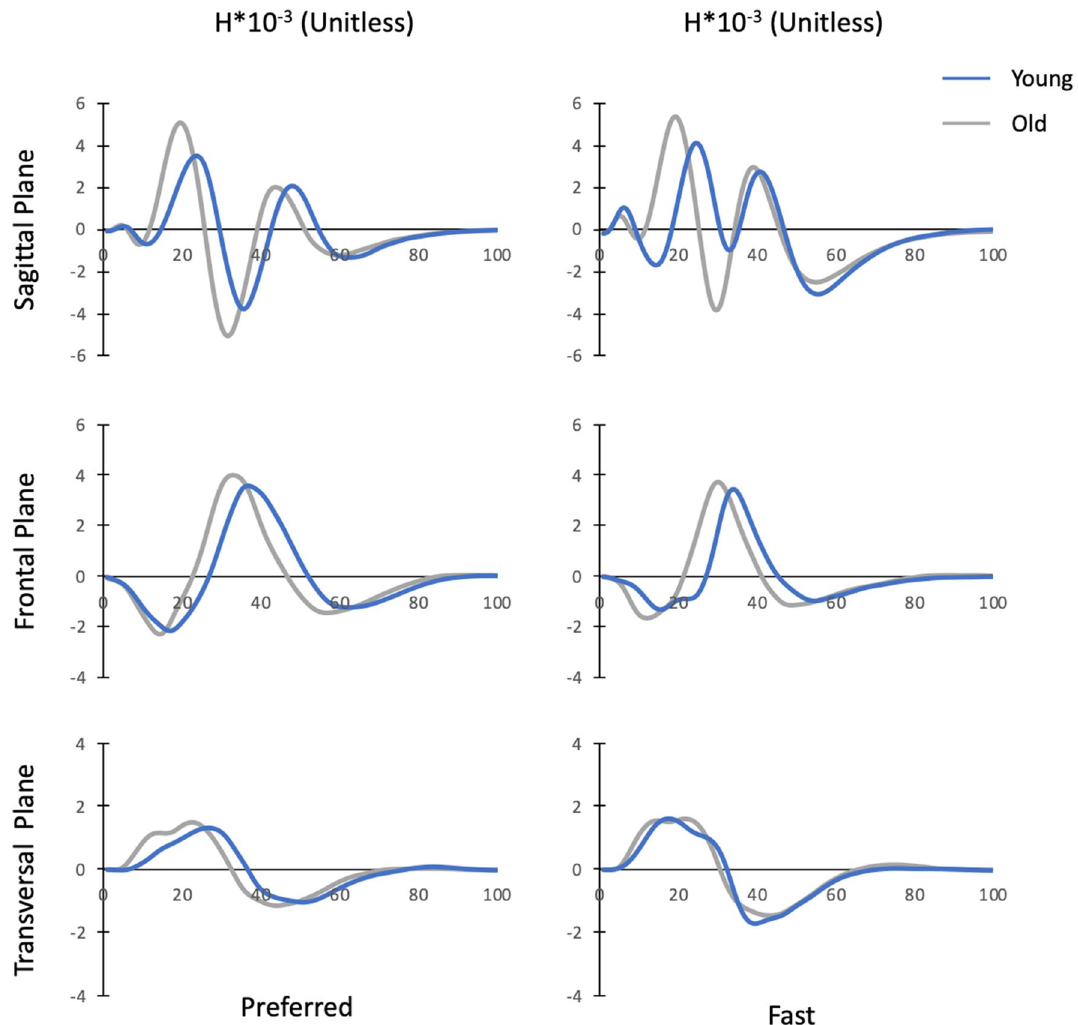
Figure 2. Mean normalized whole-body angular momentum (H) over the entire stepping movement (0–100%) for old and young individuals in both speed conditions. H was normalized by body mass, body height and · l ( g = 9.81 m s −2 and l = body (cid:31) g ( P < 0.001, η p 2 = 0.61). The angular momenta of these segments were higher in the fast condition than in the preferred condition. Regarding the segmental contributions to total absolute H (Fig. 5), the ANOVA revealed no significant Group × Speed interaction effect in the sagittal plane ( P > 0.05, η p2 = 0.003–0.02). In contrast, there was a significant group effect for the trunk ( P < 0.05, η p2 = 0.13) and leg ( P < 0.05, η p2 = 0.14) contributions. Compared to younger adults, older participants had higher trunk contribution and smaller leg contribution to total absolute H. A speed effect was found for the trunk ( P < 0.001, η p2 = 0.46), leg ( P < 0.001, η p2 = 0.53) and arm ( P < 0.001, η p2 = 0.54) contributions. The trunk and arm contributions increased significantly with speed, while the leg contribution decreased. Frontal plane. Statistical analysis revealed no effect of group or interaction for the angular momenta of all segments in the frontal plane ( P > 0.05, η p2 = 0.0003–0.11). Conversely, there was a speed effect for the absolute angular momenta of the arms ( P < 0.001, η p2 = 0.43) and legs ( P < 0.001; η p2 = 0.64). With the increase in speed, arm angular momentum increased while leg angular momentum decreased. Regarding the contributions of the segments to total absolute H (Fig. 5), no group or interaction effect was found in the frontal plane ( P > 0.05, η p2 = 0.0001–0.08). Nevertheless, a significant speed effect was revealed for the trunk ( P < 0.01, η p2 = 0.26), leg ( P < 0.001, η p2 = 0.64) and arm ( P < 0.001, η p2 = 0.64) contributions. While the contribution of the arms and trunk increased with speed, the contribution of the legs decreased. Transversal plane. No effect of group or interaction was found for the angular momenta of body segments in the transversal plane ( P > 0.05, η p 2 = 0.001–0.07). In contrast, a speed effect was found for angular momenta of